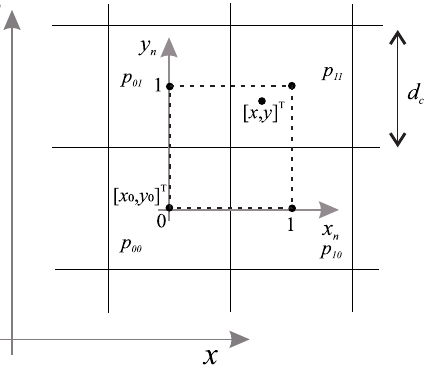
Figure 2. Detail of bilinear interpolation: selection of four neighboring cells with discrete potentials p ij and coordinate normalization within the dashed rectangle connecting the centers of the